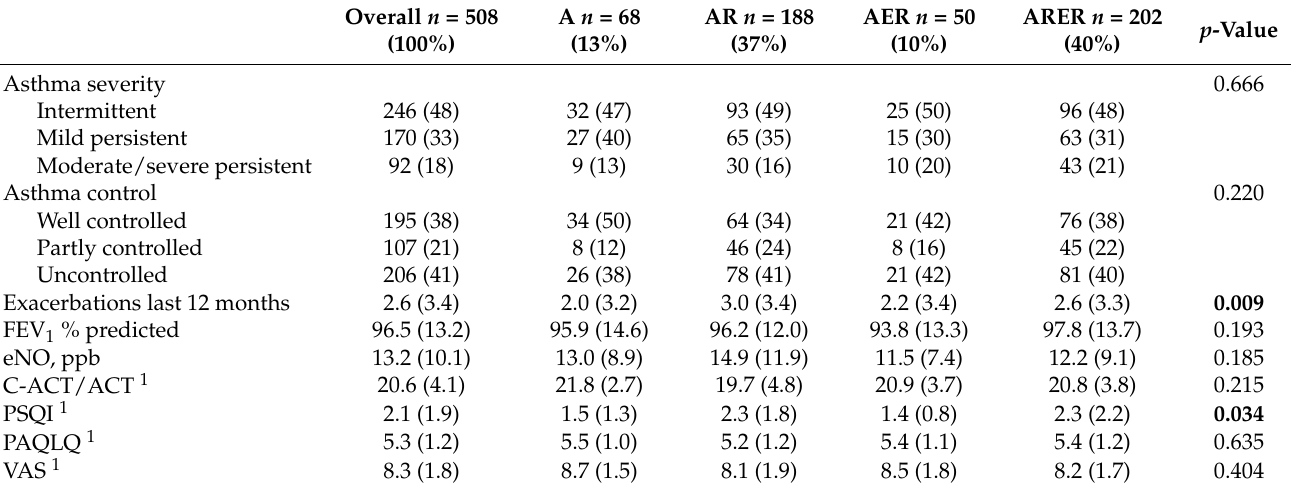
Table 4. Indicators of disease burden by comorbidity group.